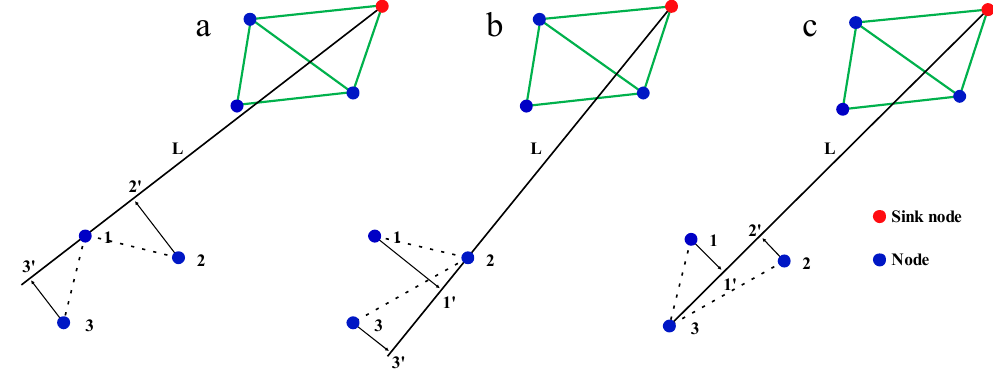
Figure 7. The direction of transmission of node information. ( a ) Nodes 2 and 3 neighbored node 1. The projection position of node 2 is 2’, and 2’ is between sink node and node 1. The projection position of node 3 is 3’ and it is on the extension line L; ( b ) Neighbor nodes of node 2 are node 1 and node 3. The projection positions of node 1 and node 3 are 1’ and 3’, the 1’ and 3’ are both on the extension line L; ( c ) Neighbor nodes of node 3 are node 1 and node 2. The projection positions of neighbor nodes were 1’ and 2’, the 1’ and 2’ are both between sink node and node 3.